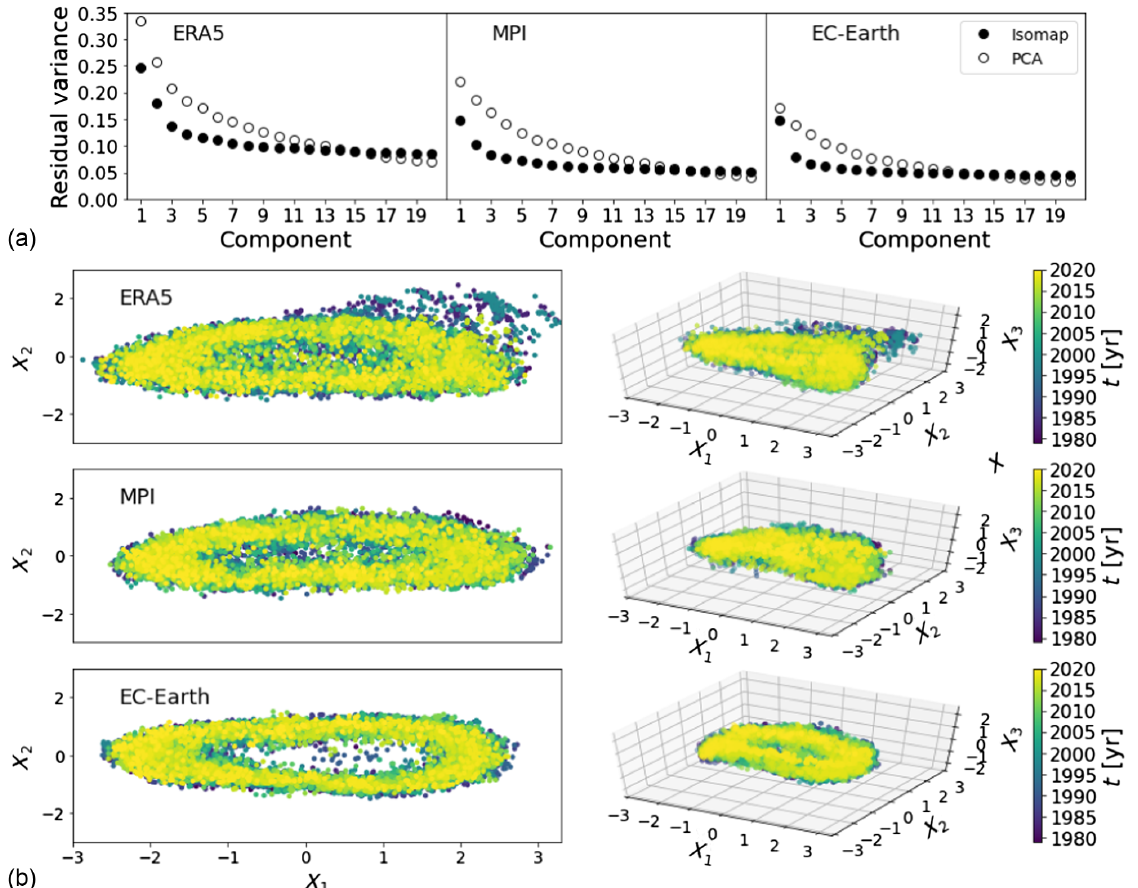
FIG. 1. Dimensionality reduction of the tropical Pacific climate retaining seasonality and trends. (a) Residual variance of PCA and Isomap for ERA5 and the two CMIP6 models (MPI and EC-Earth). (b) Low-dimensional, Isomap projections (first two or three components, respectively) of the three datasets; Isomap components are indicated as X 1 , X 2 , X 3 , respectively. Each point encodes the multivariate state of the tropical Pacific Ocean at a given day from January 1979 to December 2019. Projections have been standardized to unit